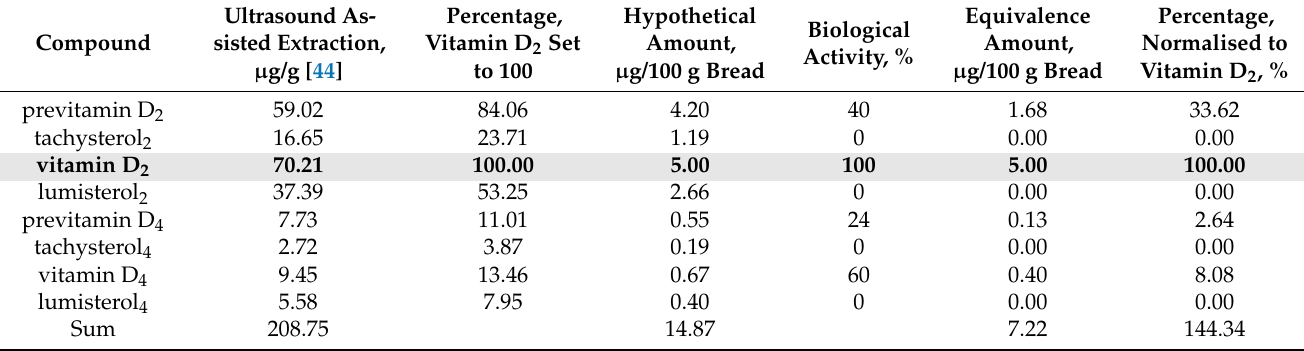
Table 5. Yield from ultrasound assisted extraction of oyster mushrooms after UV irradiation, determined by HPLC. The yields for the different identified vitamin D isomers as well as precursors and photoinduced side products are provided, as well as the percentage of each compound normalised to the identified vitamin D 2 amount. The hypothetical amounts of all the precursors and photoinduced side products in vitamin D 2 -fortified bread based on an amount of 5 µ g per 100 g bread is